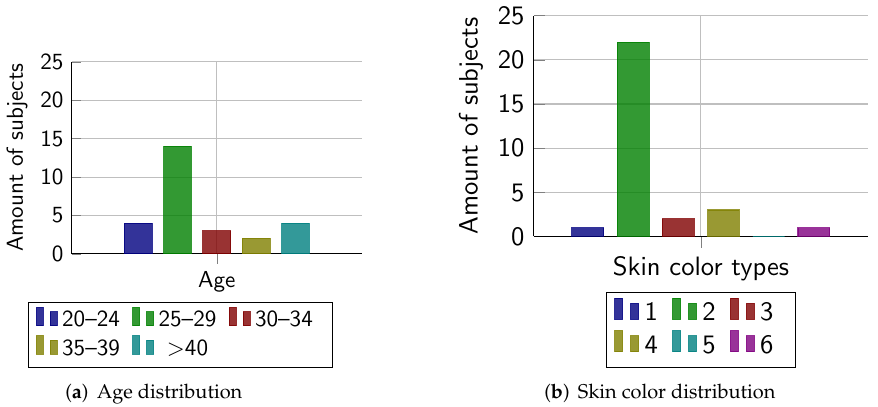
Figure 7. Distribution of age and skin color, according to Fitzpatrick metric [32] of the